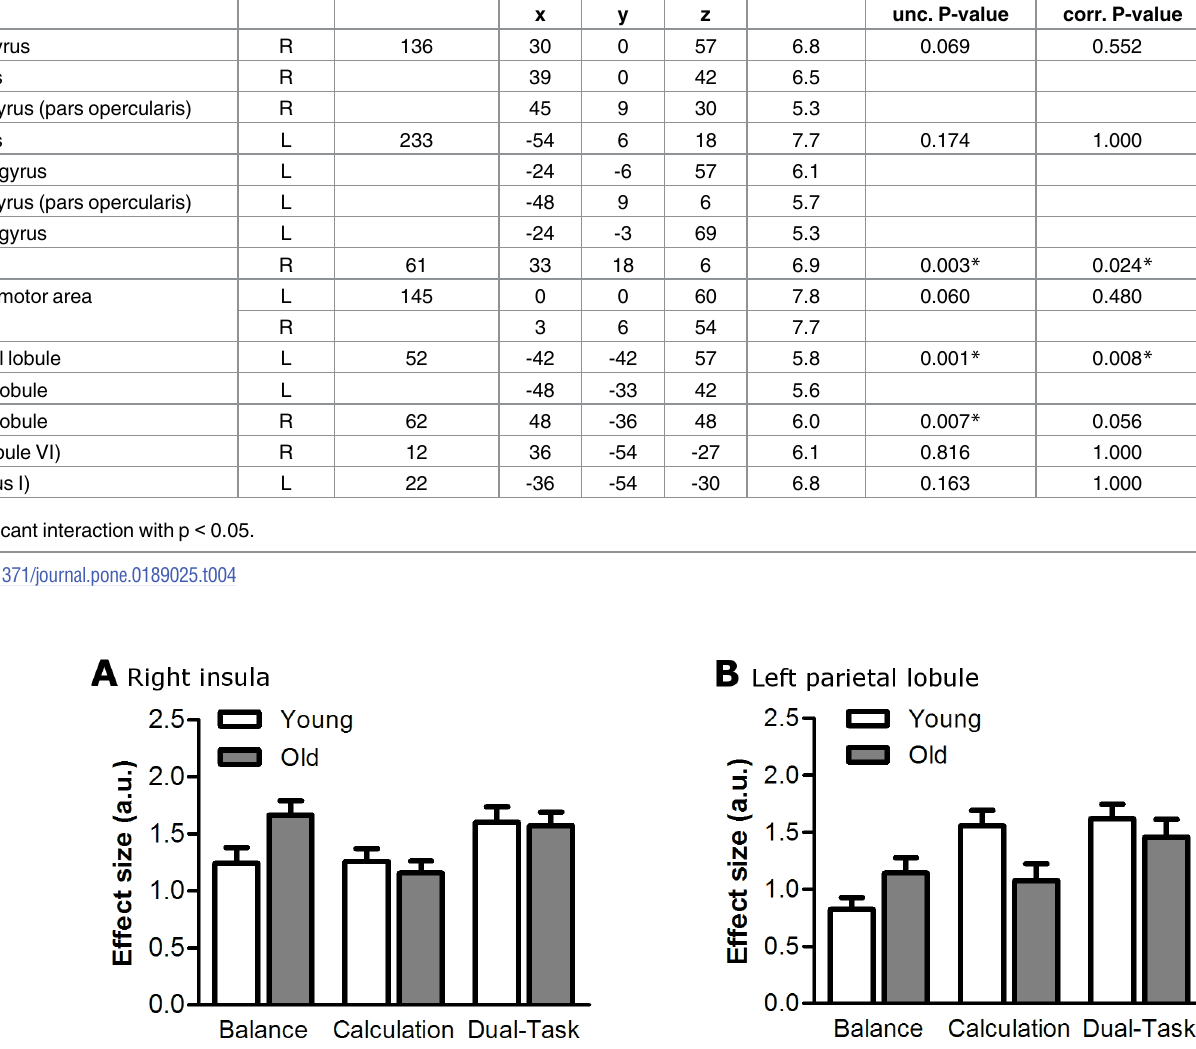
Fig 4. Group data for young and old adults, showing the mean ± standard error of the BOLD response (in arbitraryunits) during balance, calculation, and dual-tasking, in the right insula (A) and left parietal lobule (B).